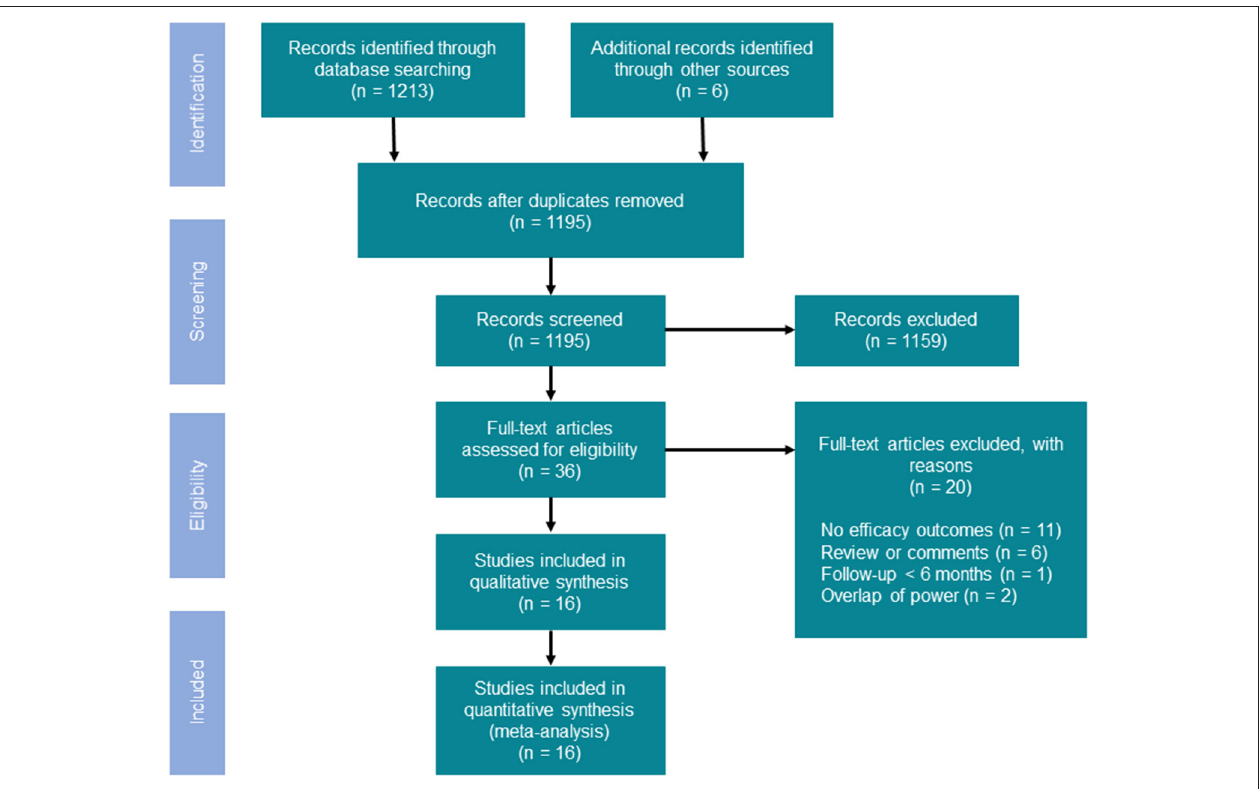
FIGURE 1 | Flowchart of the search strategy.